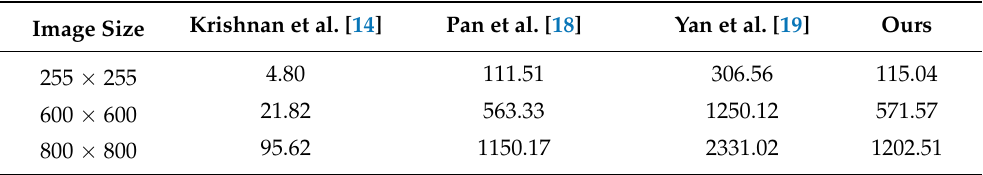
Table 3. Running time (s) of competing